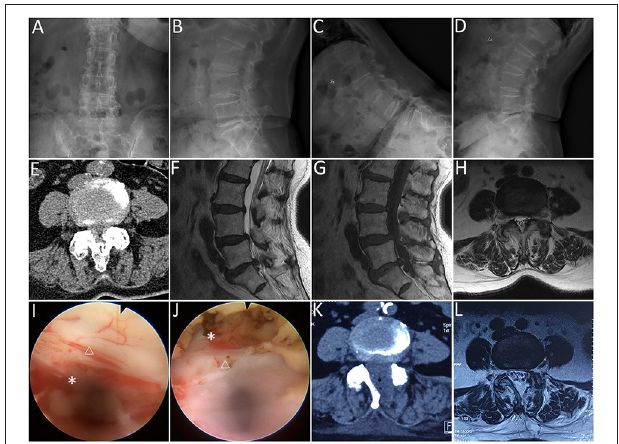
FIGURE 2 | Lumbar endoscopic unilateral laminotomy bilateral decompression (LE-ULBD) performed on a 77-year-old female patient diagnosed with L4-L5 lumbar spinal stenosis with degenerative spondylolisthesis. (A,B) preoperative anteroposterior and lateral plain radiographs; (C,D) preoperative flexion and extension radiographs; (E) preoperative computed tomography (CT) scans; (F–H) preoperative magnetic resonance imaging (MRI) scans; (I,J) medial facetectomy was performed to decompress the lateral recess and ensure adequate decompression of the traversing nerve root; (K) postoperative